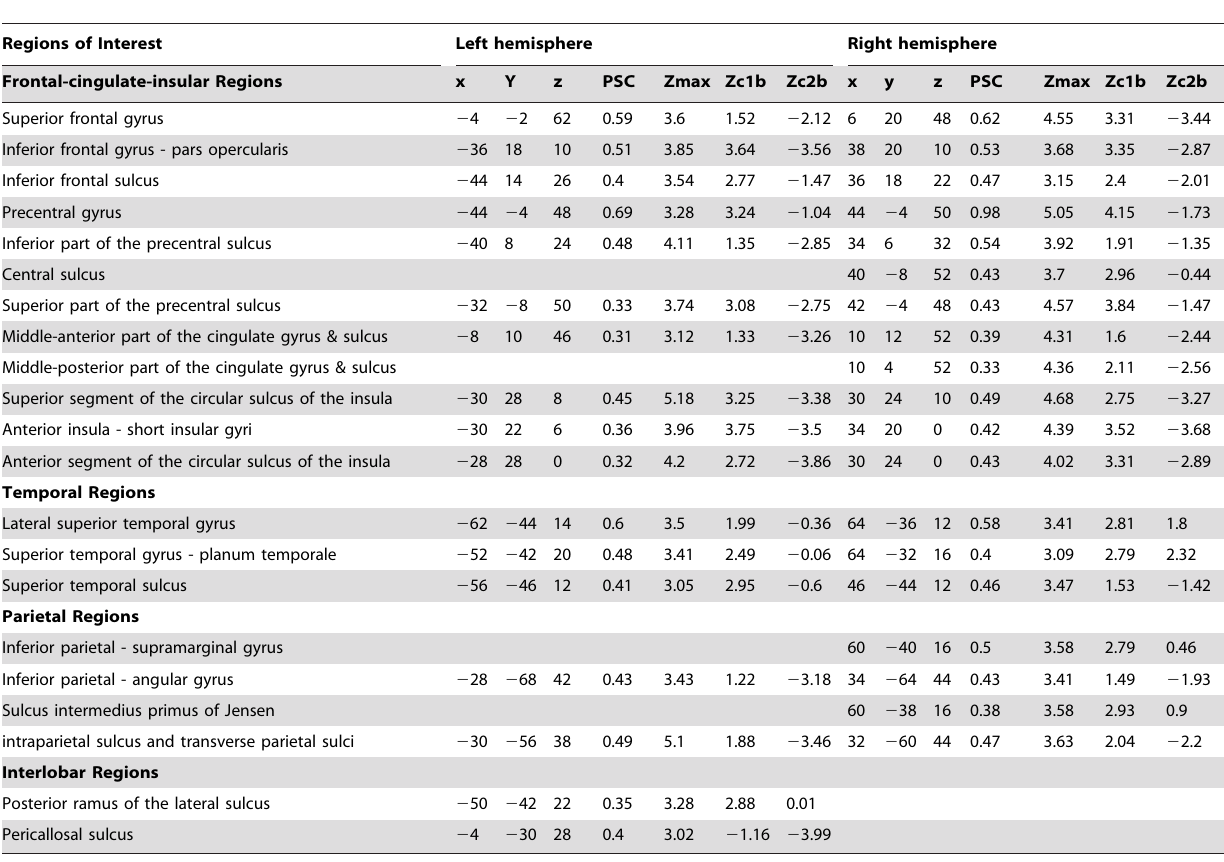
Table 1. Brain regions activated in the Cue + standards vs. Standards only contrast.